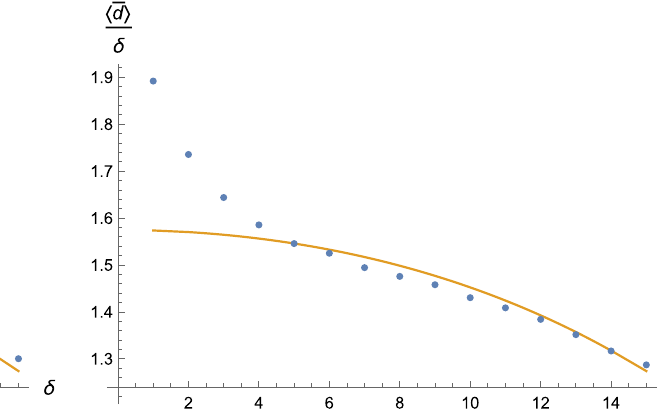
Fig. 4 Normalized average sphere distance (cid:2) ¯ d (cid:3) /δ as a function of δ , measured at volume N 41 = 75 k (left) and N 41 = 600 k (right), using the dual link distance. Best fits to a four-dimensional continuum sphere